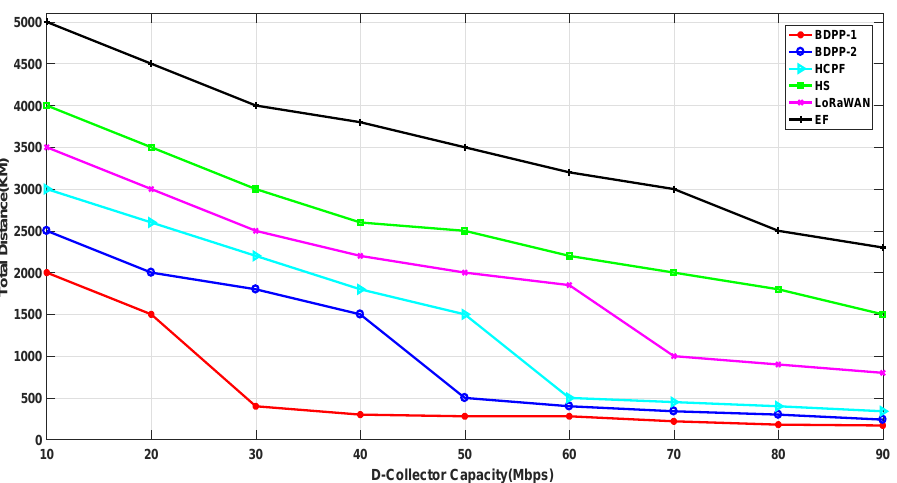
Figure 16. D-collector capacity vs. total